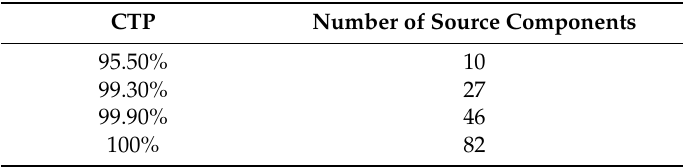
Table 2. Cumulative Target-component Percentage-influence (CTP) and the number of contributing source